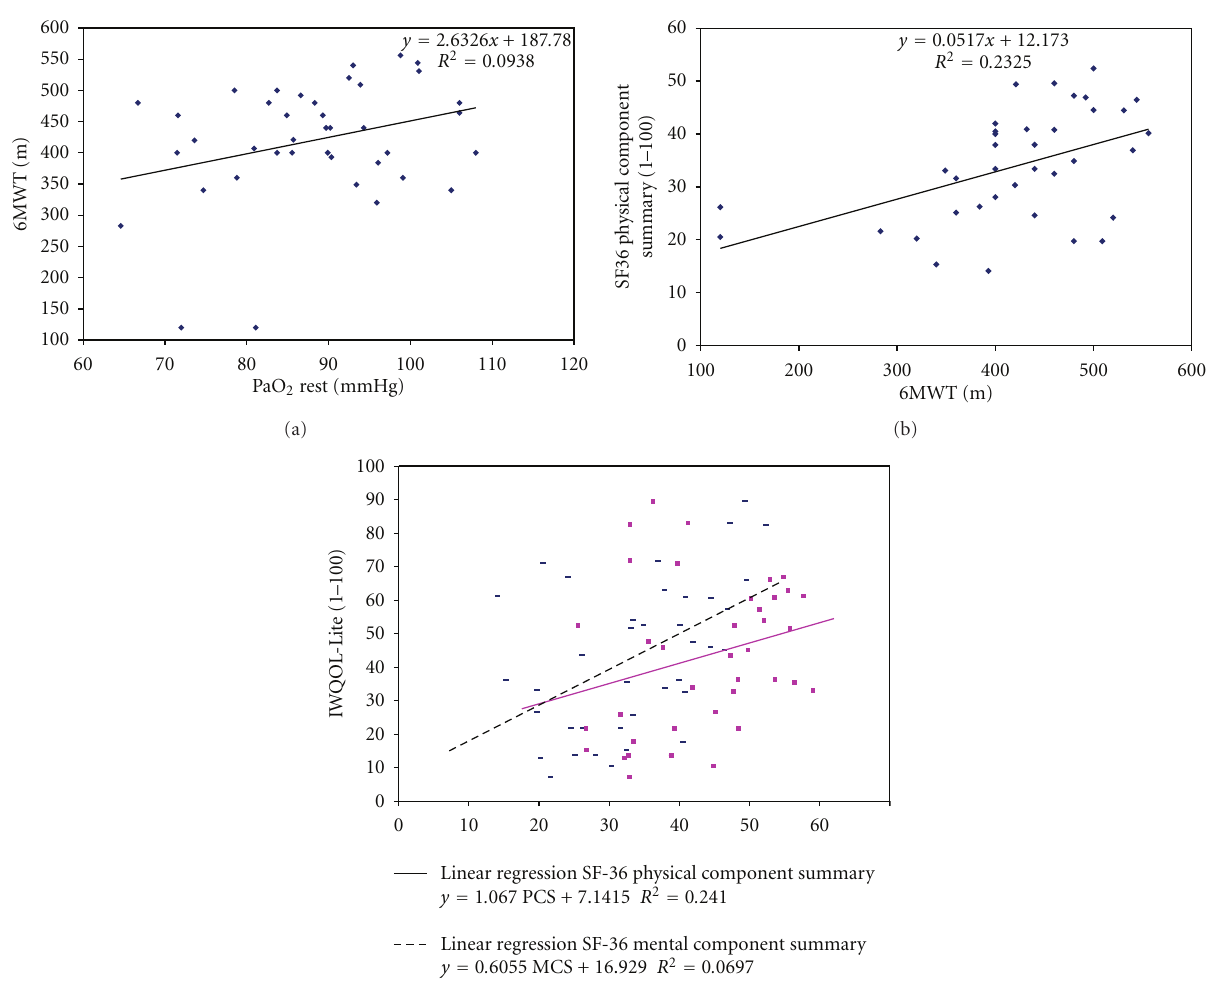
Figure 2: Univariate regressions: (a) relationship between PaO 2 at rest and 6-minute walk test. (b) Relationship between 6-minute walk test and SF-36 Physical Component Summary. (c) In dashed line, the relationship between SF-36 Physical Component Summary (PCS) and IWQOL, and in solid line, the relationship between SF-36 Mental Component Summary (MCS) and IWQOL.